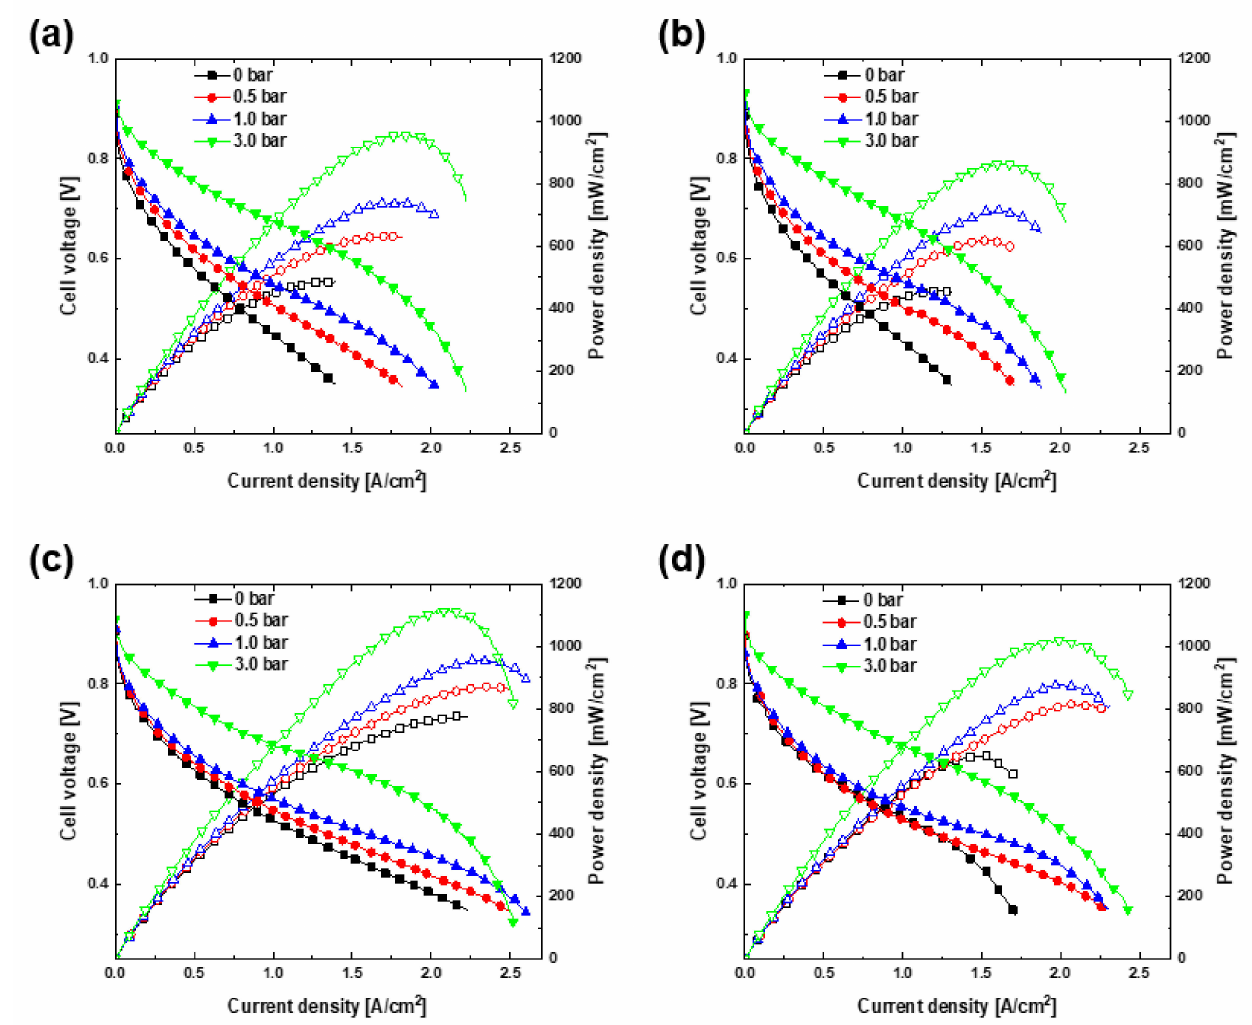
Figure 2. Performance comparison of ( a ) A1C1, ( b ) A3C1, ( c ) A1C3, and ( d )